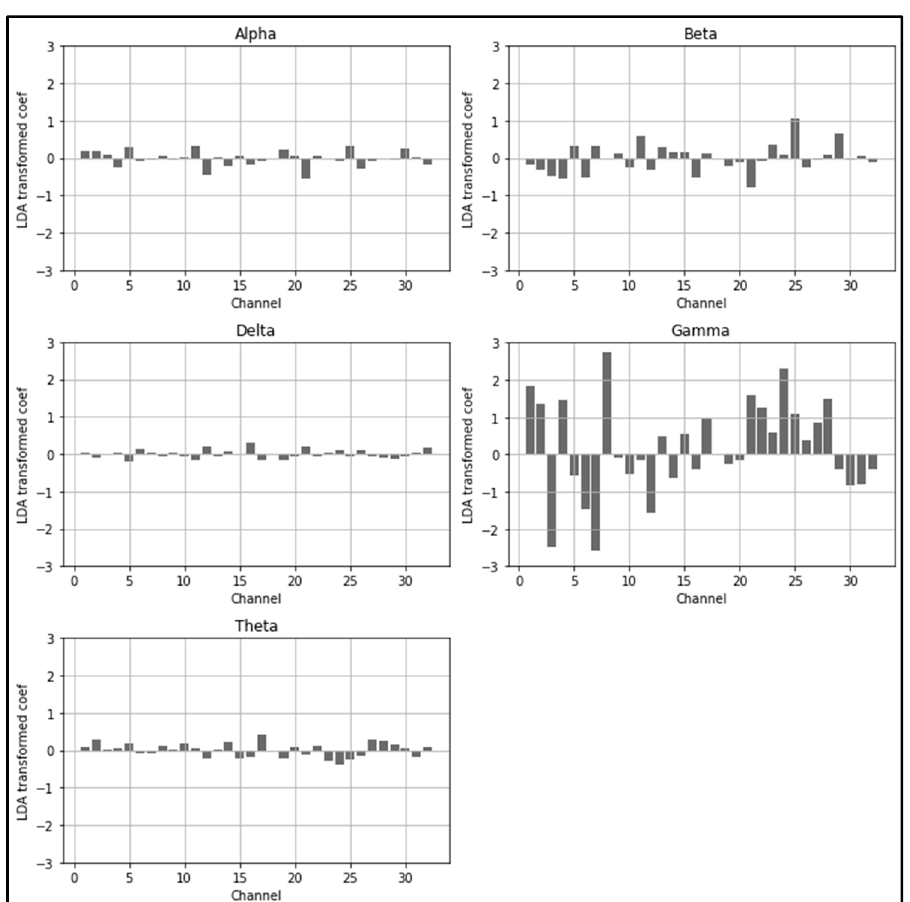
Figure 9. Linear discriminant analysis random forest (LDARF) classifier coefficients for each channel. Gamma brain wave had a significant influence on determining mouth and nose breathing.